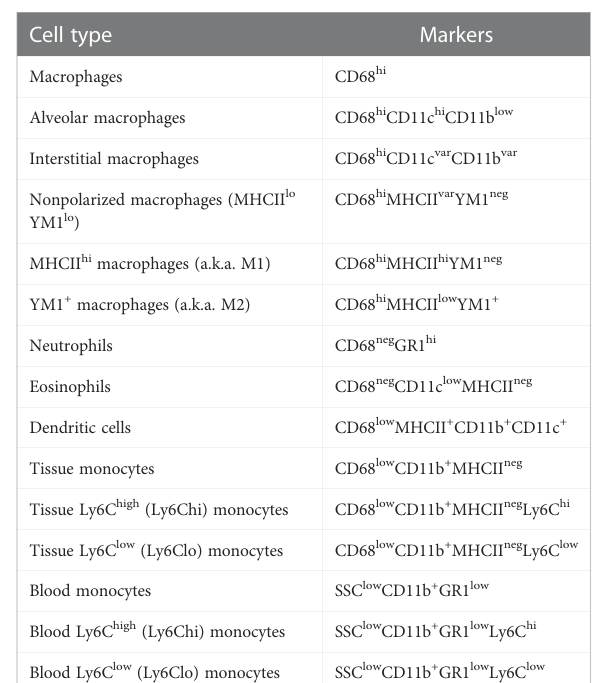
TABLE 2 Markers used to characterize different populations of myeloid